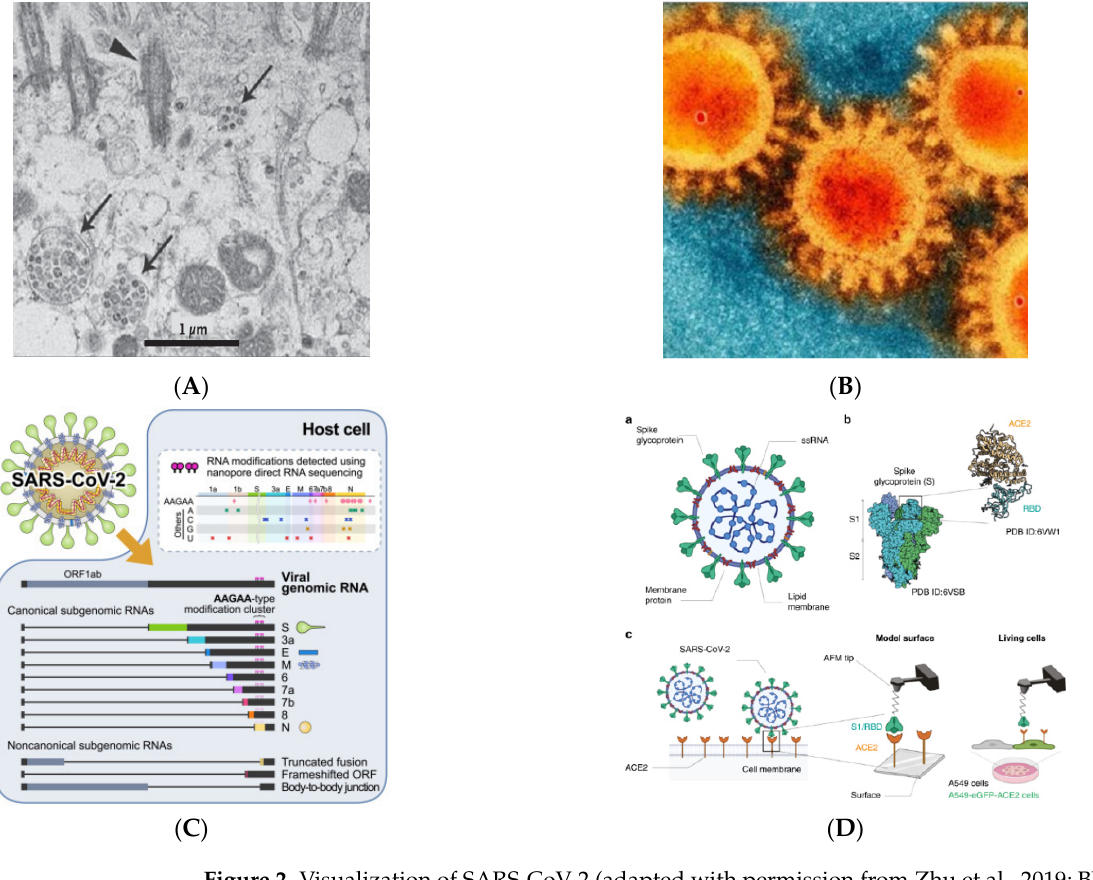
Figure 2. Visualization of SARS-CoV-2 (adapted with permission from Zhu et al., 2019; Bharadwaj et al., 2020; Kim et al., 2020 and Yang et al., 2020) [8–11] ( A ) Visualization of SARS-CoV-2 with Transmission Electron Microscopy (Virus particles in the human airway epithelial cell). Arrowheads represent extracellular virus particles, while arrows represent inclusion bodies generated by virus components; ( B ) SEM image of SARS-CoV-2 (Large protrusions emerged out from the spike of viral surface, which forms a crown-like appearance, that’s why given the name ‘coronavirus’ (Latin word means crown)); ( C ) Transcriptomic (The full-length genomic RNA and nine major subgenomic